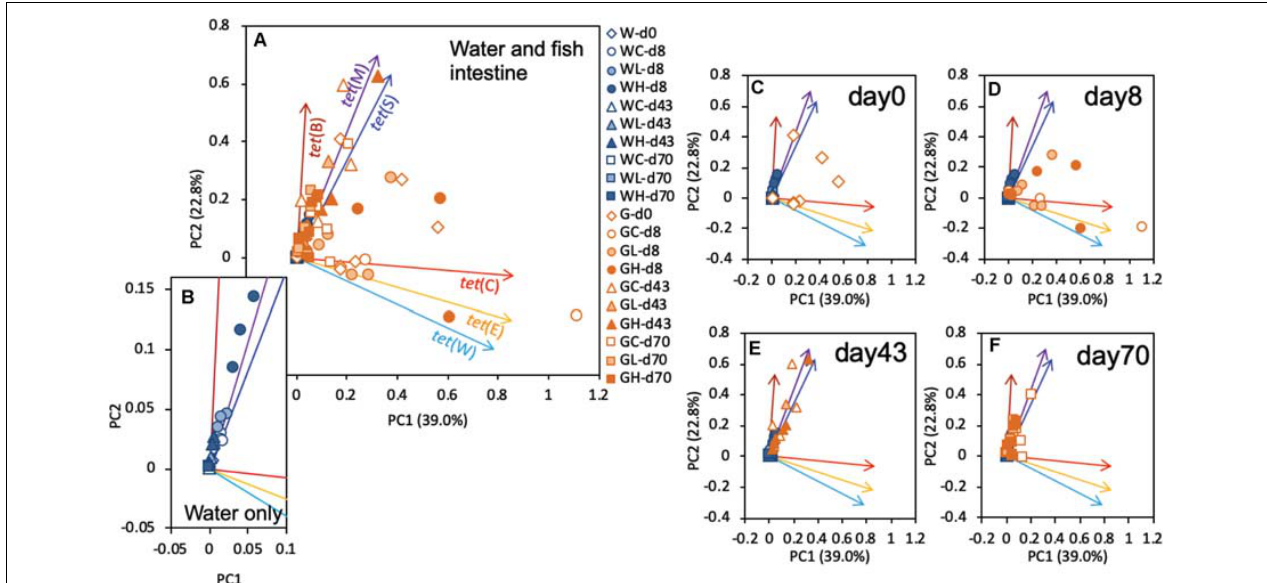
FIGURE 5 | Plots of principal components 1 (PC1) and 2 (PC2) resulting from the principal component analysis (PCA) based on the tet gene profiles of all samples. (A) Results for all samples are plotted with representative symbols: the initial W or G in the name of each sample indicates whether the sample was obtained from the rearing water or fish gut, respectively; the second character (C, L, or H) indicates whether the sample was obtained from the control, low-OTC, or high-OTC tank, respectively; and the remaining part of each sample name (-dxx) indicates the experimental time point of the sample (where d = day and xx = the day number). The subsequent panels present the same results replotted by extracting only the data for (B) water samples, (C) water samples and day-0 fish intestine, (D) day-8 fish intestine, (E) day-43 fish intestine, or (F) day-70 fish intestine.